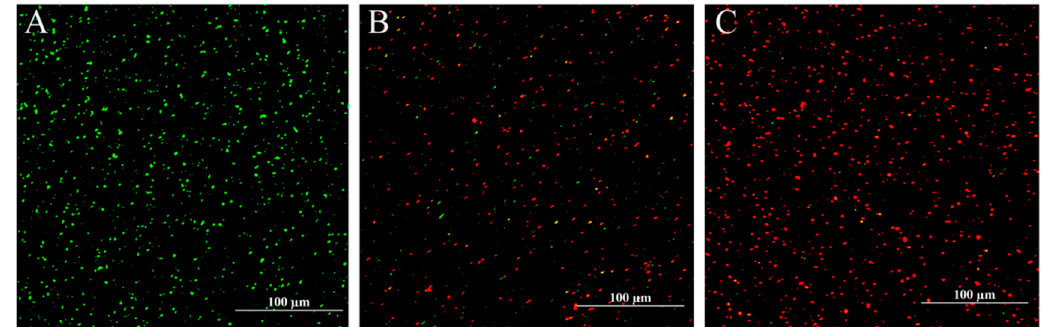
Figure 7. CLSM-based observation of changes in the membrane integrity of untreated S. Typhimurium ATCC 14028 cells ( A ) versus those treated with CoQ 0 at MIC ( B ) and 2MIC ( C ), as demonstrated by the proportions of green versus red fluorescence.